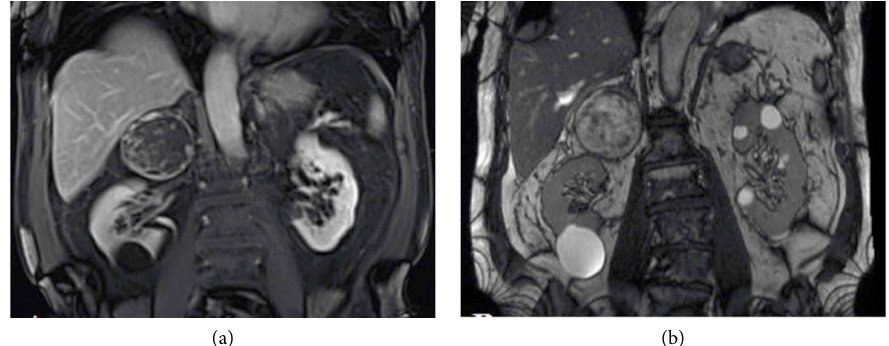
Figure 1: Enhanced magnetic resonance images (MRI) of the abdomen and pelvis with gadolinium. (a) Coronal view of an in-phase T1-weighted image identifying a large suprarenal mass measuring around 7.3 × 6.5 × 6 cm occupying the space of the right adrenal gland, showing a significant rim enhancement with marked vascularity. (b) Coronal view of a T2-weighted image identifying the similar right suprarenal mass with heterogeneous component inside it, possessing various signal